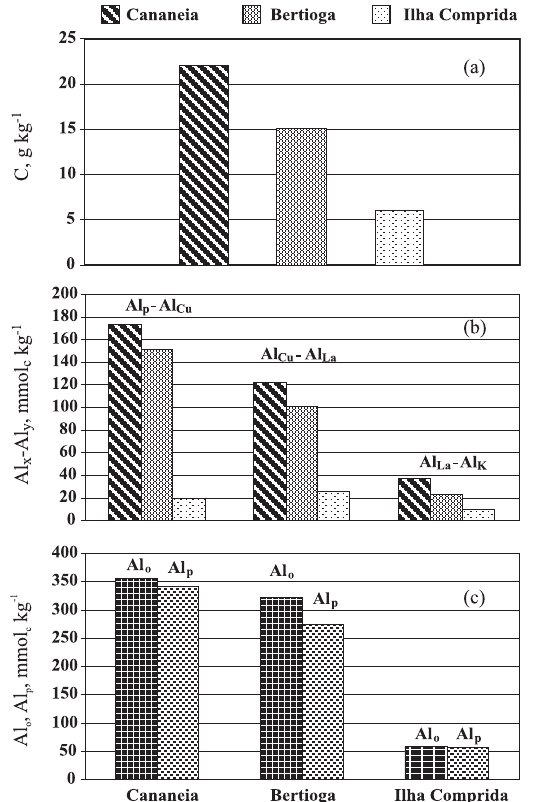
Figura 3. Conteúdos médios de C (a); formas de Al (média) associado à matéria orgânica com diferentes graus de estabilidade – os símbolos x e y da subtração Al -Al estão especificados x y acima de cada conjunto de três barras no gráfico (b); e teores médios de alumínio extraído com oxalato (Al ) e pirofosfato (Al ) (c) de horizontes o p